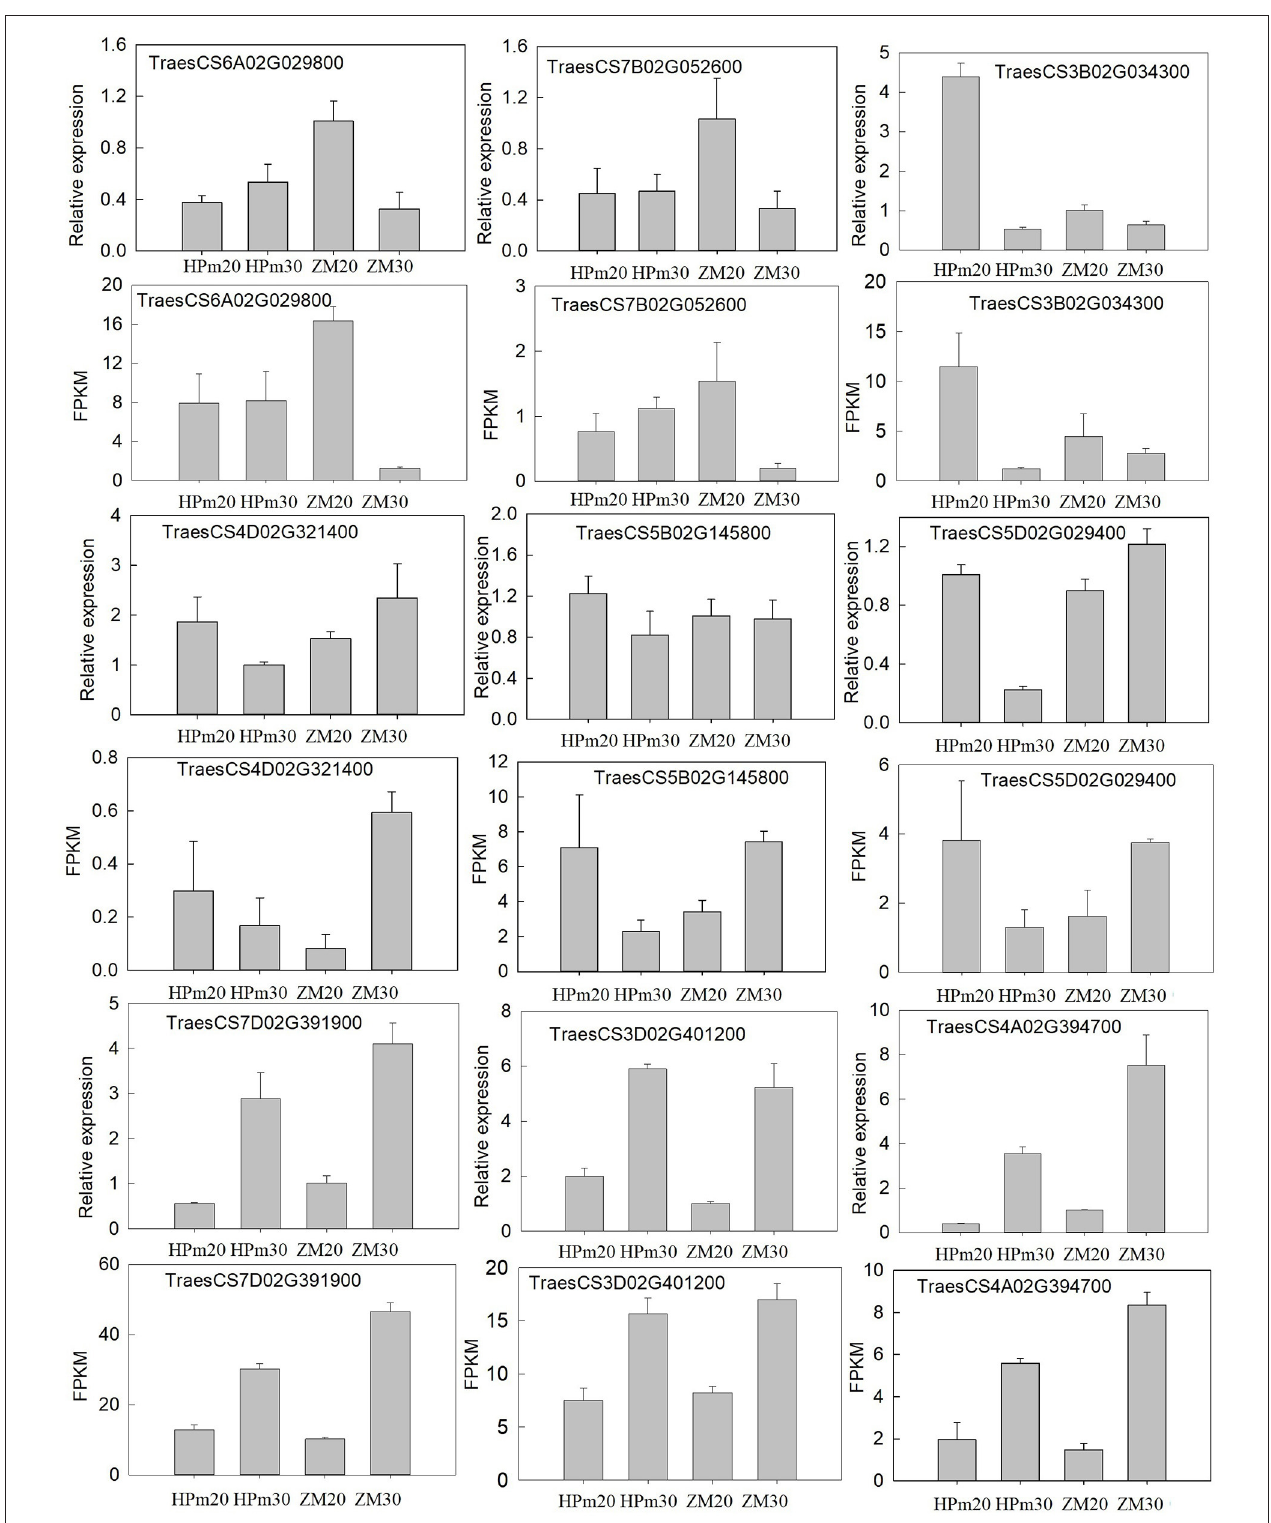
FIGURE 7 | Validation of the expression patterns of nine representative DEGs during the grain filling stage. Relative expression level determined using real-time PCR; FPKM determined using RNA-Seq. HPm20 and HPm30 are samples from HPM512 at 20 and 30 DAA; ZM20 and ZM30 are samples from cultivar ZM22 at 20 and 30 DAA,